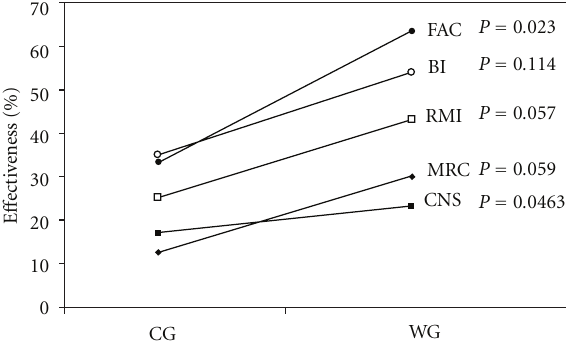
Figure 2: E ff ectiveness for control group (CG) and Walkaide group (WG) in terms of FAC (filled circles), BI (empty circles), RMI (empty squares), MRC (filled rhombus), and CNS (filled squares) scores with the relevant P values of comparison between